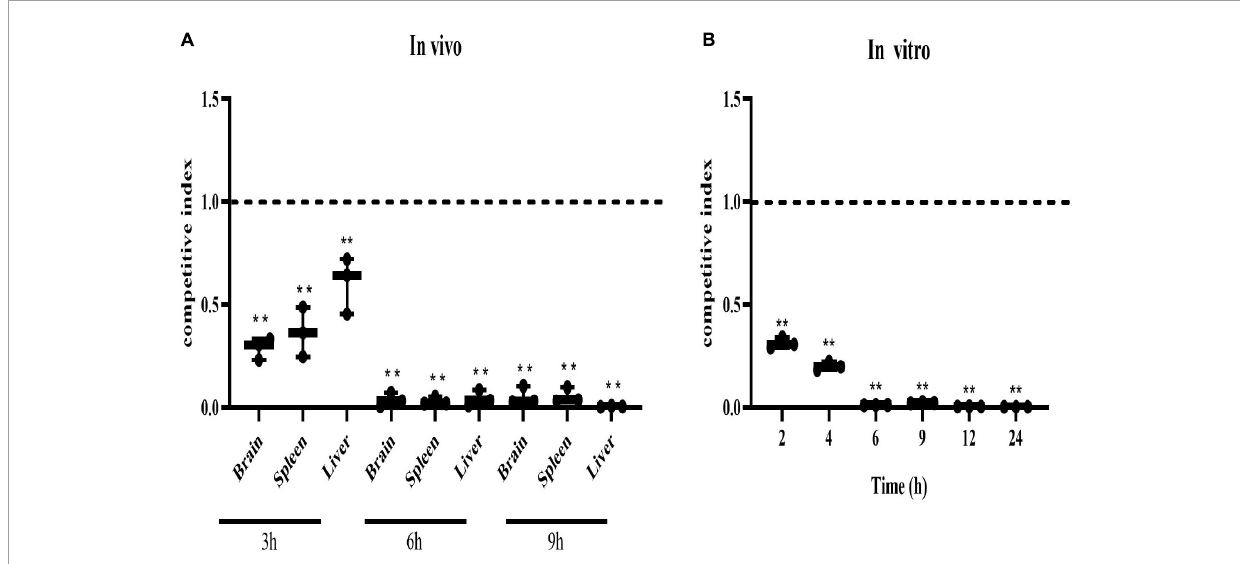
FIGURE4 Competitive index of the (cid:49) SaeRS mutant vs. total bacterial count. In vivo , the brain, spleen, and liver of tilapia ( Oreochromis niloticus ) infected with the mixed inoculum of the S. agalactiae THN0901 and (cid:49) SaeRS strains were sampled and counted after 3, 6, and 12 h, respectively (A) . In vitro , the mixture of S. agalactiae THN0901 and (cid:49) SaeRS stains was inoculated in a fresh brain heart infusion (BHI) medium, and the bacterial liquid was sampled and counted after 2, 4, 6, 9, 12, and 24 h, respectively. Samples were tested in triplicate. A competitive index of 0.5 indicated that the (cid:49) SaeRS mutant strain with THN0901 strain was proliferating equally (B) . Each experiment was performed in triplicate, and data were presented as mean ± standard deviation (SD), *: 0.01 < P < 0.05, **: P < 0.01.